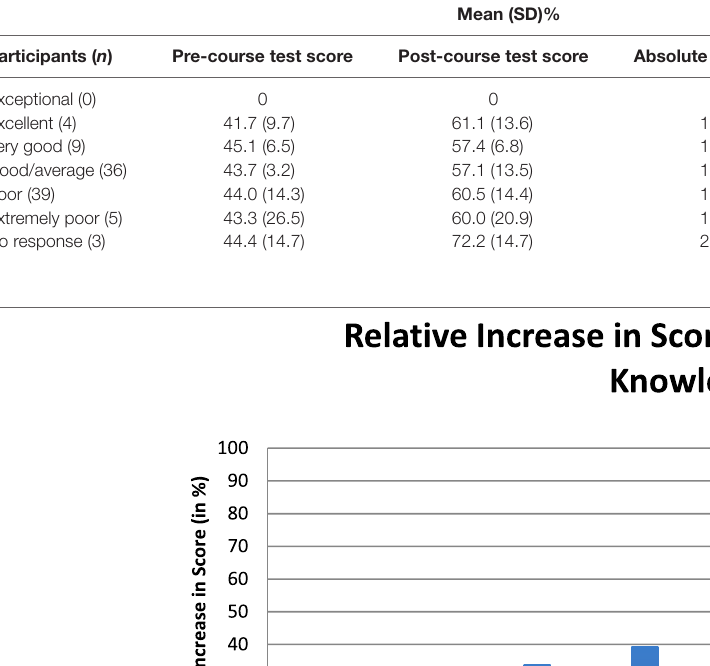
TaBle 3 | Change in scores from pre-course to post-course questionnaire by level of evidence-based medicine (EBM) experience, participant